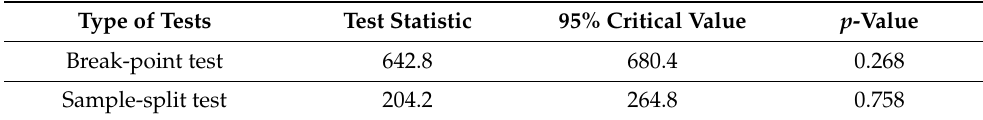
Table 2. Standard structural change test